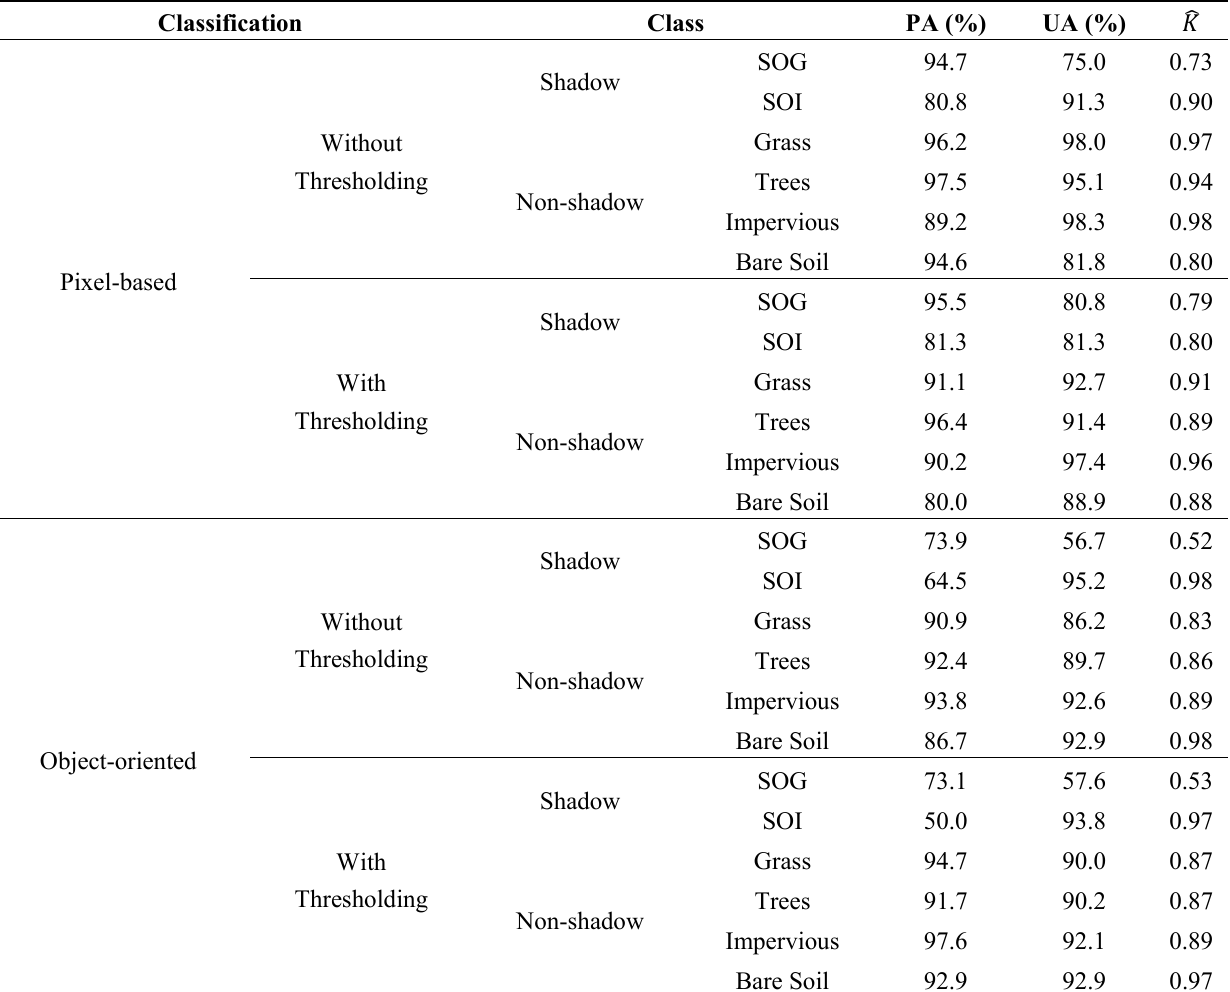
Table 5. The producer’s accuracy (PA), user’s accuracy (UA), and Kappa statistic ( (cid:1837)(cid:3553) ) of detected shadow and classified land cover with the pixel-based and object-oriented methods a